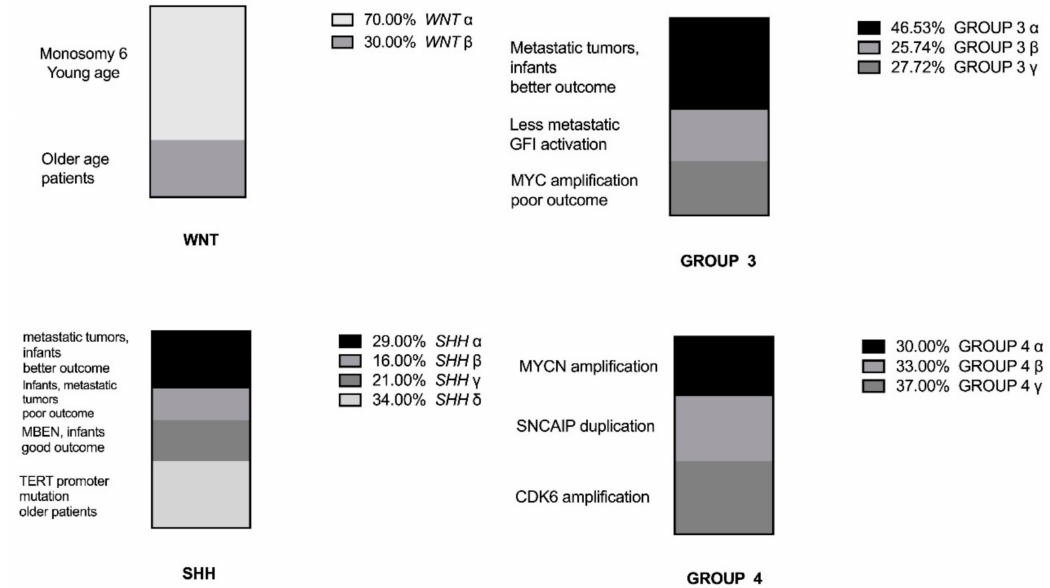
Figure 7. Main somatic genetic abnormalities observed in medulloblastomas subdivided into four groups. Data are reported in Cavalli et al., 2017 [170]. MBEN: medulloblastoma with extensive modularity, SHH: sonic